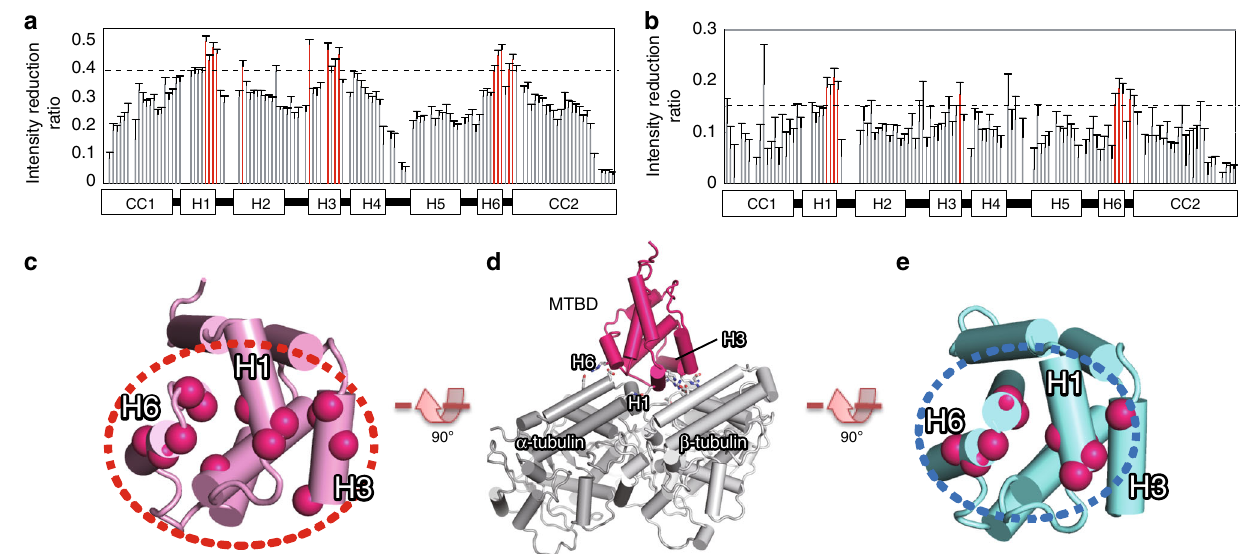
Fig. 5 Identi fi cation of the low- and high-af fi nity interface by TCS (transferred cross-saturation) experiments. a , b Plots of the intensity reduction ratio of the amide resonances of ( a ) MTBD-High and ( b ) MTBD-Low in TCS experiments. The error bars are calculated based on signal-to-noise ratios. Residues showing an intensity reduction ratio greater than 0.15 for MTBD-Low or greater than 0.4 for MTBD-High are colored red. Signals with standard deviations greater than 0.1 were excluded. Although V3133 in H2, which is not exposed to the surface of MTBD, showed a signi fi cant intensity reduction in TCS experiments of MTBD-High, this reduction was presumably due to spin diffusion from H3 residues. Source data are provided as a Source Data File. c – e Mapping of the residues with signi fi cant intensity reduction in TCS experiments of ( c ) MTBD-High and ( e ) MTBD-Low. The overall orientation of MTBD with respect to MTs is shown in ( d